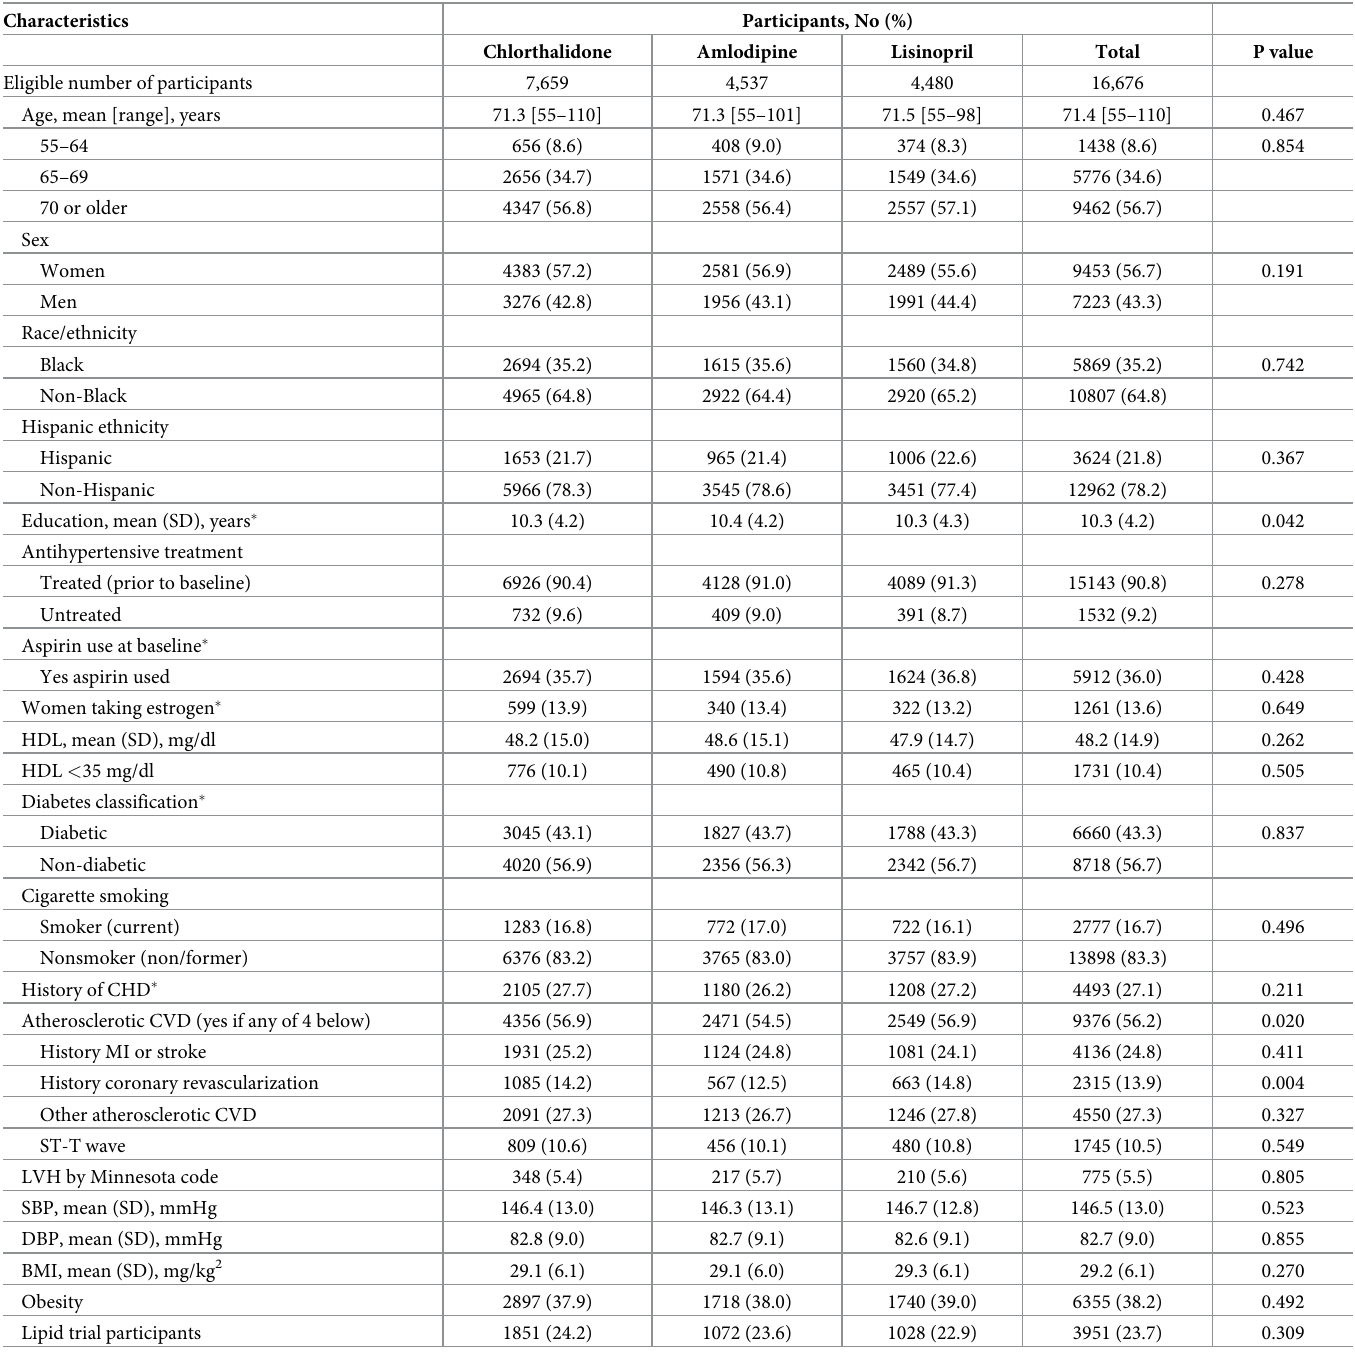
Table 1. Baseline characteristics of participants by randomized treatment